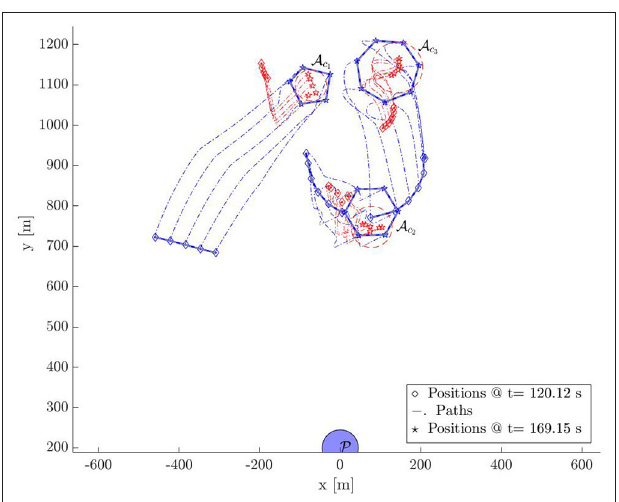
FIGURE 11 | Multi-Swarm StringNet Herding: Snapshot 3.